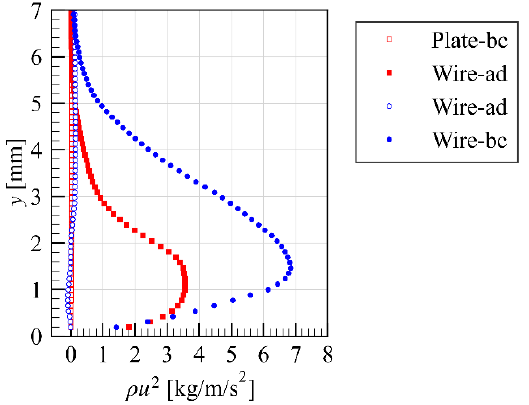
Figure 21. Momentum flux at the left and right side of the CV of the plate- and wire-PA.